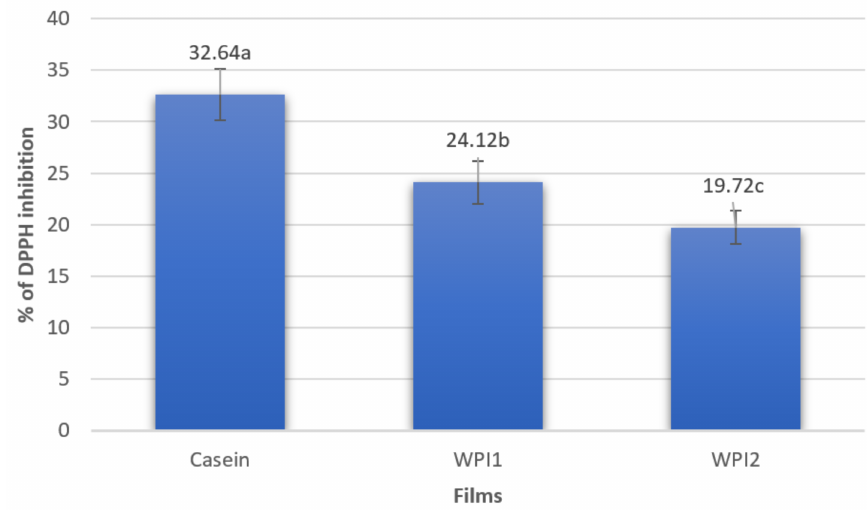
Figure 2. Antioxidant capacity of milk protein-based edible films reported as % of 1,1-diphenyl- 2-picrylhydrazyl (DPPH) inhibition. Different letter indicates significant differences ( p < 0.05) between